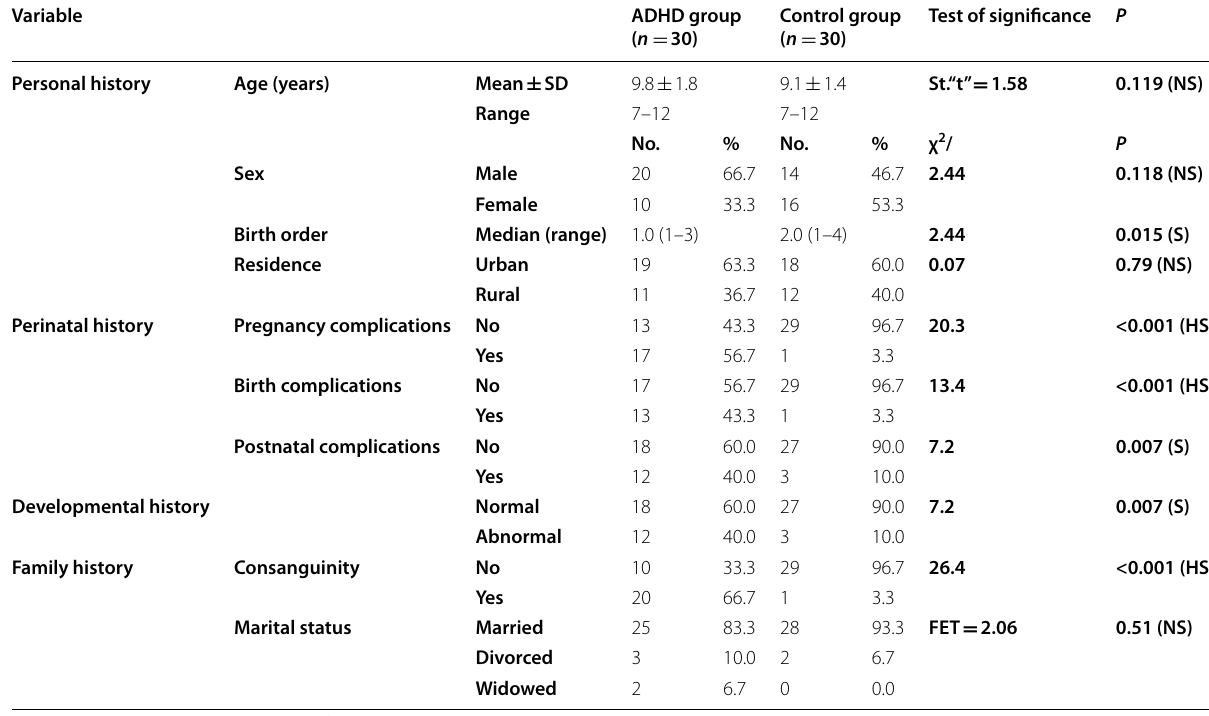
Table 1 Demographics of the studied groups